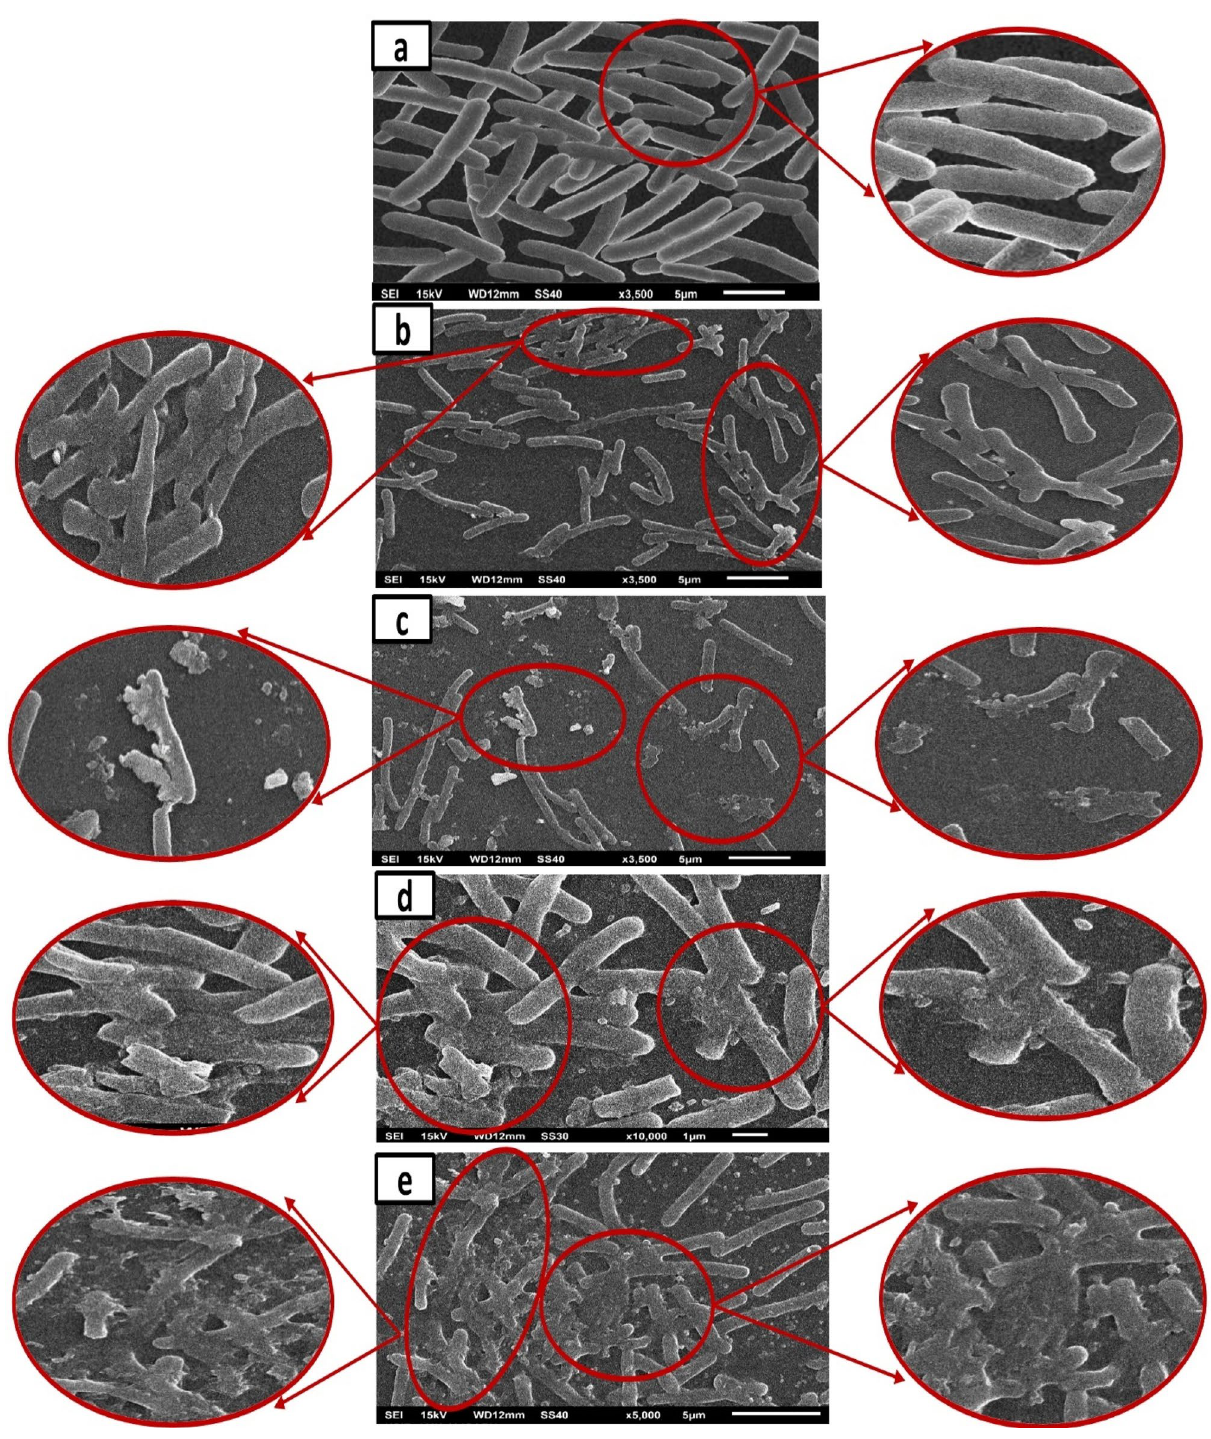
Figure 22. Scanning electron microscopy (SEM) images of E. coli cells of ( a ) untreated, ( b ) treated with MgO nanoparticles, ( c ) treated with 5% of Ni-doped MgO nanoparticles, ( d ) treated with 5% of Co-doped MgO nanoparticles, and ( e ) treated with 5% of Fe-doped MgO nanoparticles. Red circles indicate membrane regions of E. coli damaged by